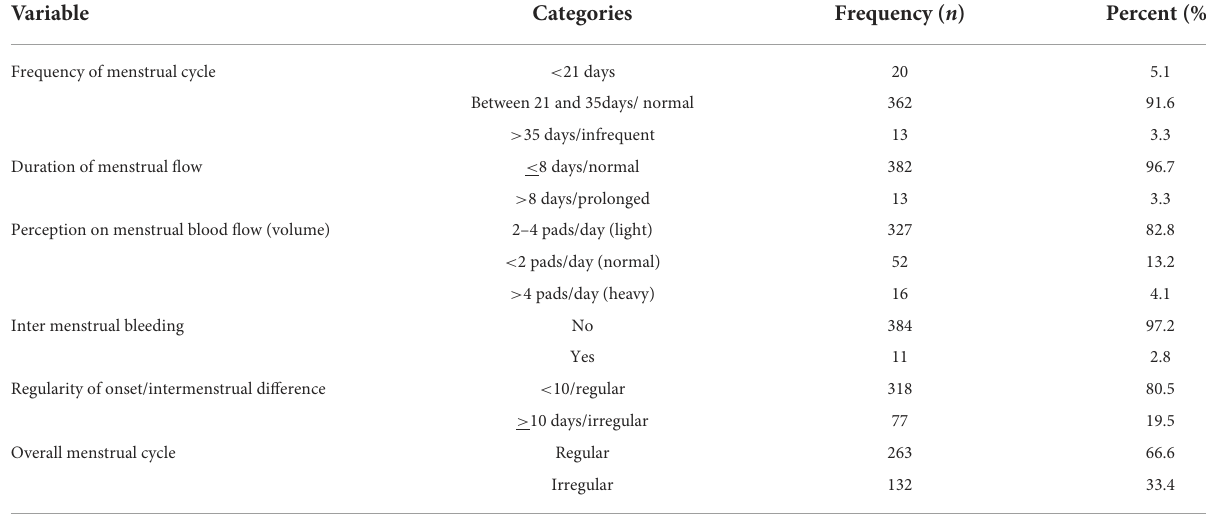
TABLE 2 Patterns of the menstrual cycle among female college students, Debre Berhan, Ethiopia, 2021 ( n = 395). Variable